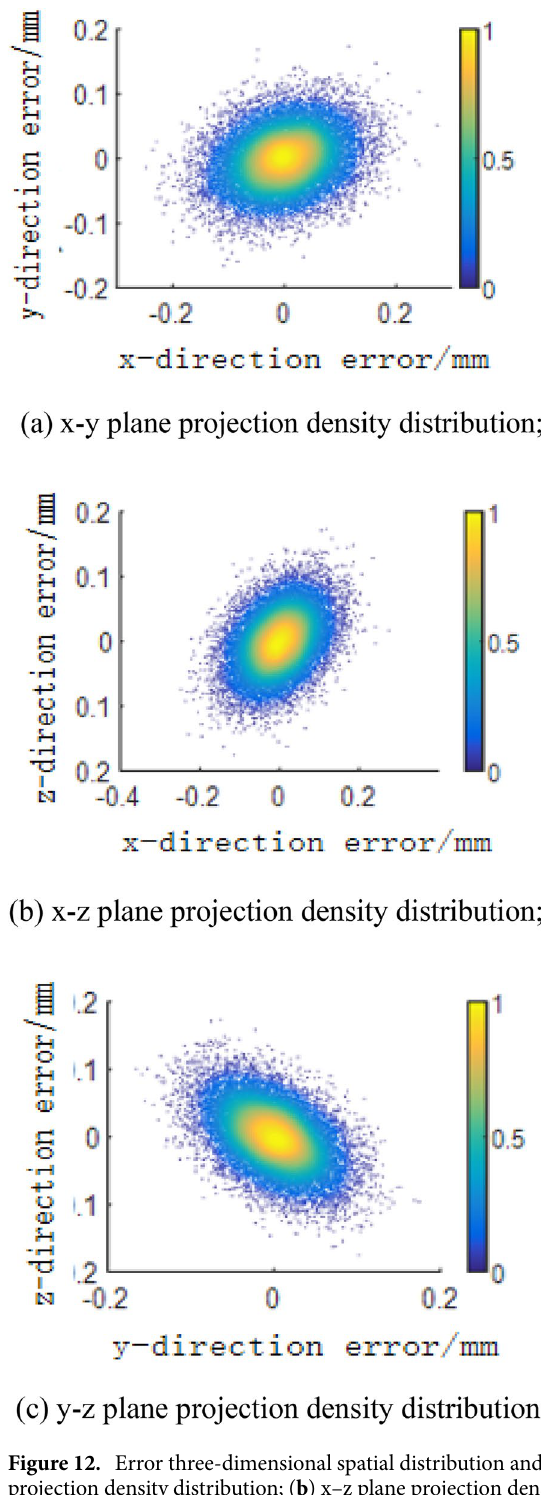
Figure 12. Error three-dimensional spatial distribution and plane projection density distribution. ( a ) x–y plane projection density distribution; ( b ) x–z plane projection density distribution; ( c ) y–z plane projection density